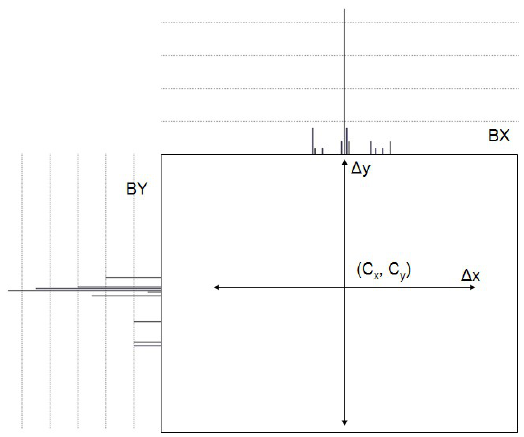
Figure 7. Distributions of two 1-D arrays in the first